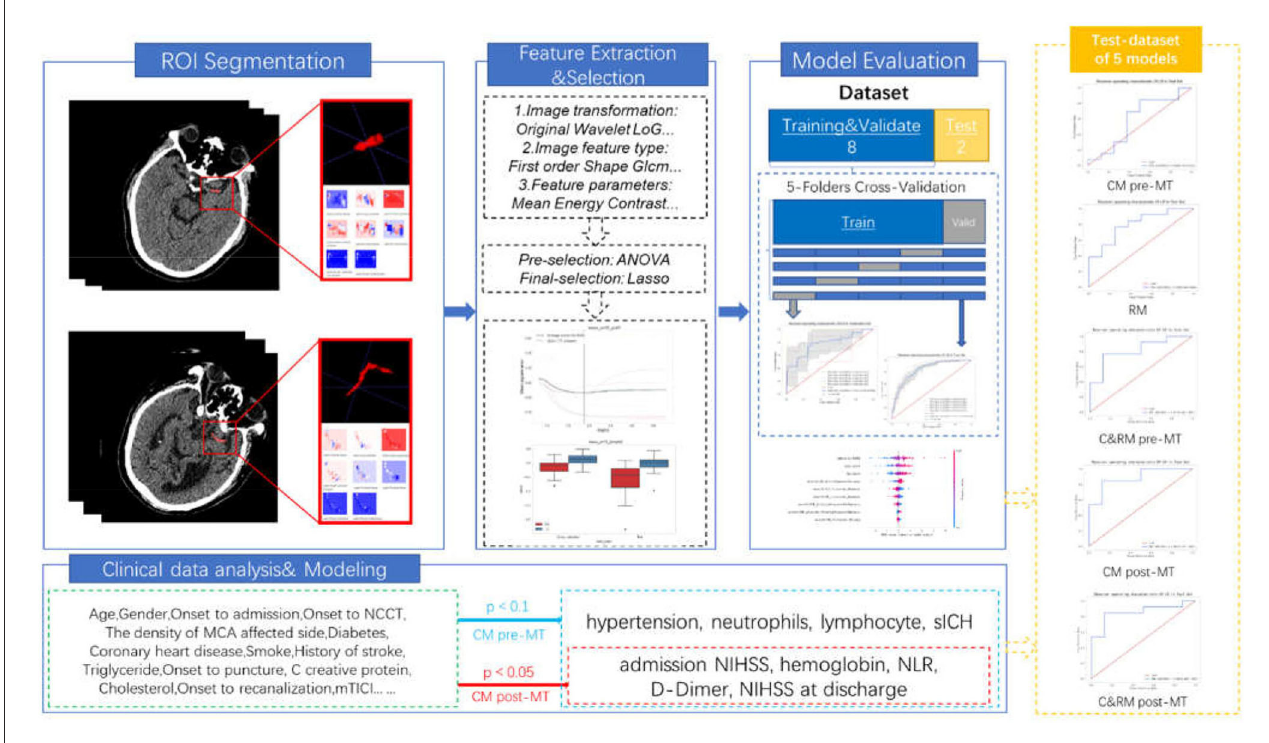
FIGURE2 The workflow of this